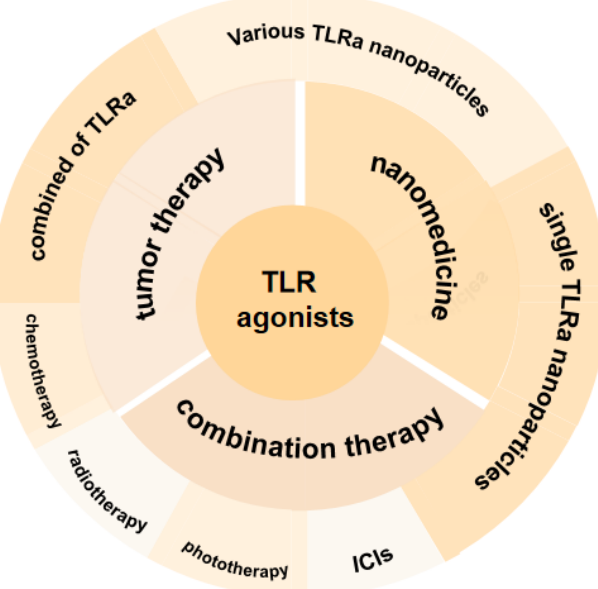
Figure 1. The mechanism underlying the role of TLRs in tumor immunity. Reprinted with permission from Ref. [21] . Copyright 2020, copyright